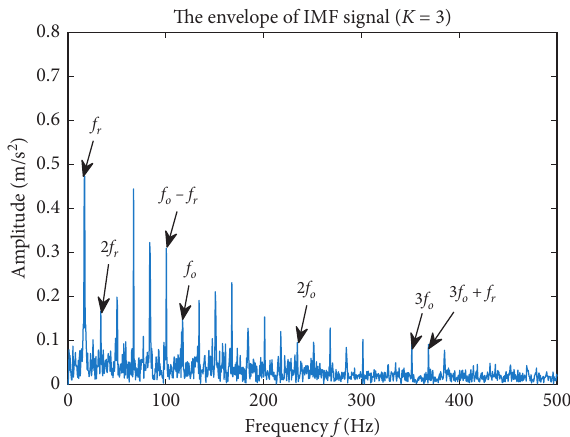
Figure 10: IMF signal envelope spectrum of outer